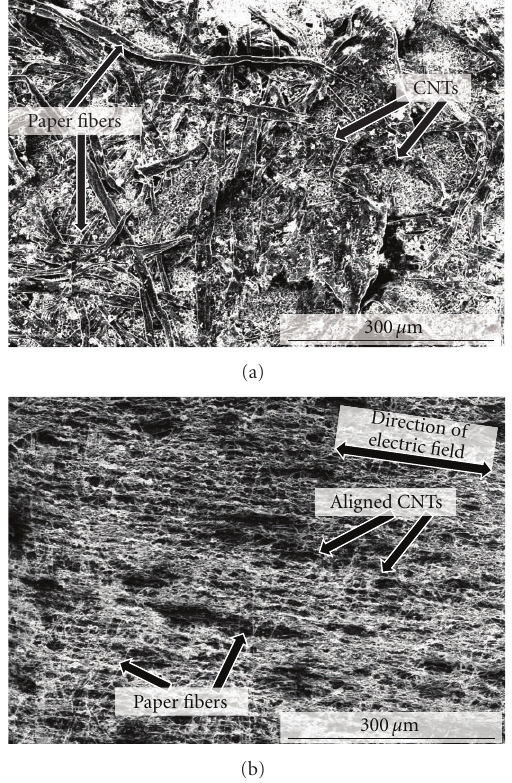
Figure 8: SEM image of CNT-composite-paper with CNT density of 0.0284 mg/cm 2 ((a) nonalignment control and (b) alignment